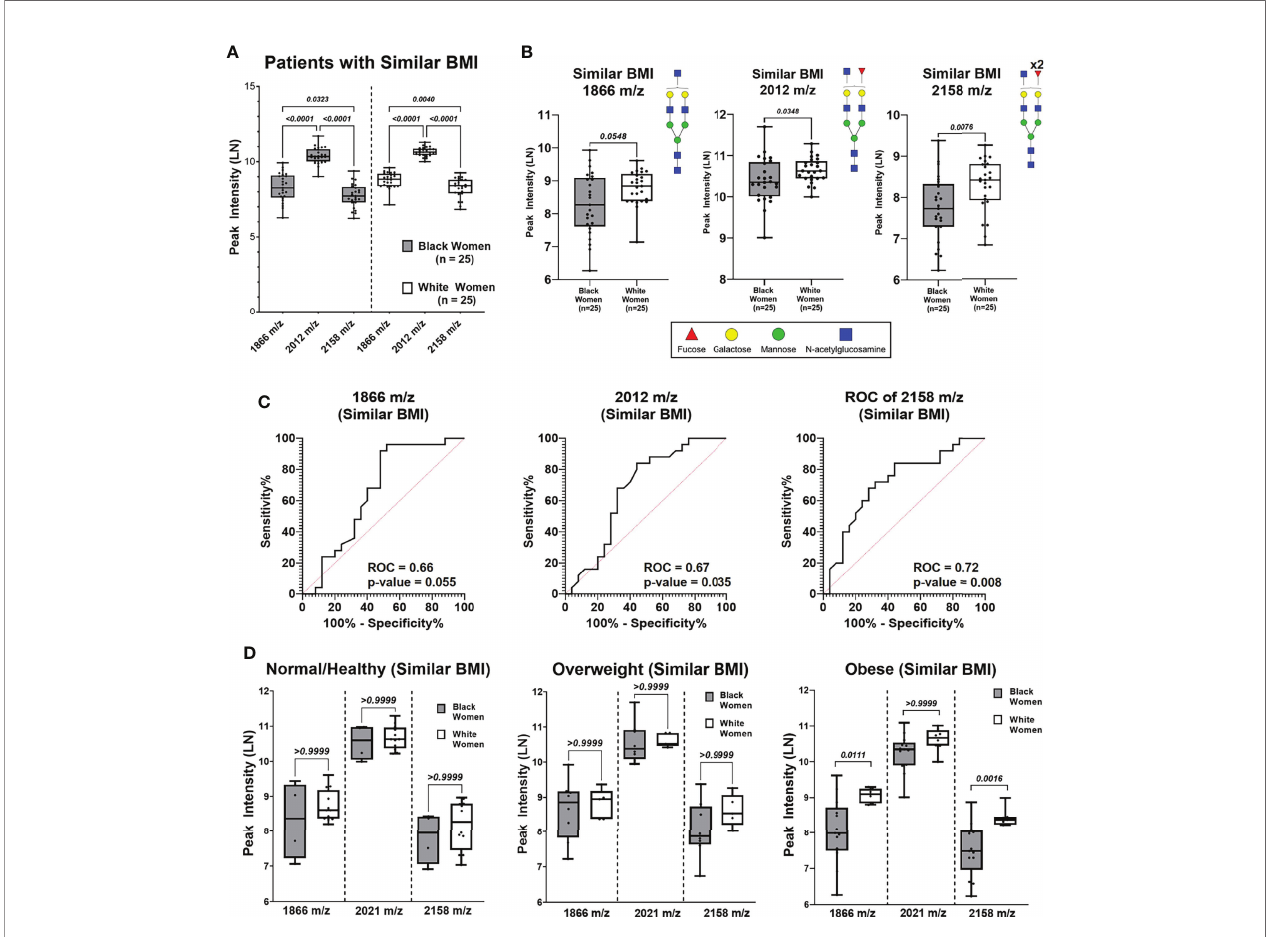
FIGURE 4 | N-Glycan peak intensify analysis based on BMI (Normal, Overweight and Obese) of patient cohort with similar BMIs. (A) Comparing peak intensi fi es between N-glycans 1866 m/z, 2012 m/z from Black and White cohorts with similar BMIs. (B) Comparison of N-glycan peak intensi fi es show WW have higher intensi fi es compared to BW for peaks 1866 m/z (p = 0.0548), 2012 m/z (p = 0.0348) and 2158 m/z (p = 0.0076) (C) Receiver operating curve (ROC) analysis of peaks 1866 m/z, 2012m/z, and 2158m/z of patient cohort with similar BMIs show area under the curve (AUC) values of 0.66 (p-value = 0.055),0.67 (p-value = 0.035), and 0.72 (p-value = 0.008), respectively. (D) Comparing Black and White women peak intensi fi es of N-glycans 1866 m/z, 2012 m/z and 2158 m/z based on BMI